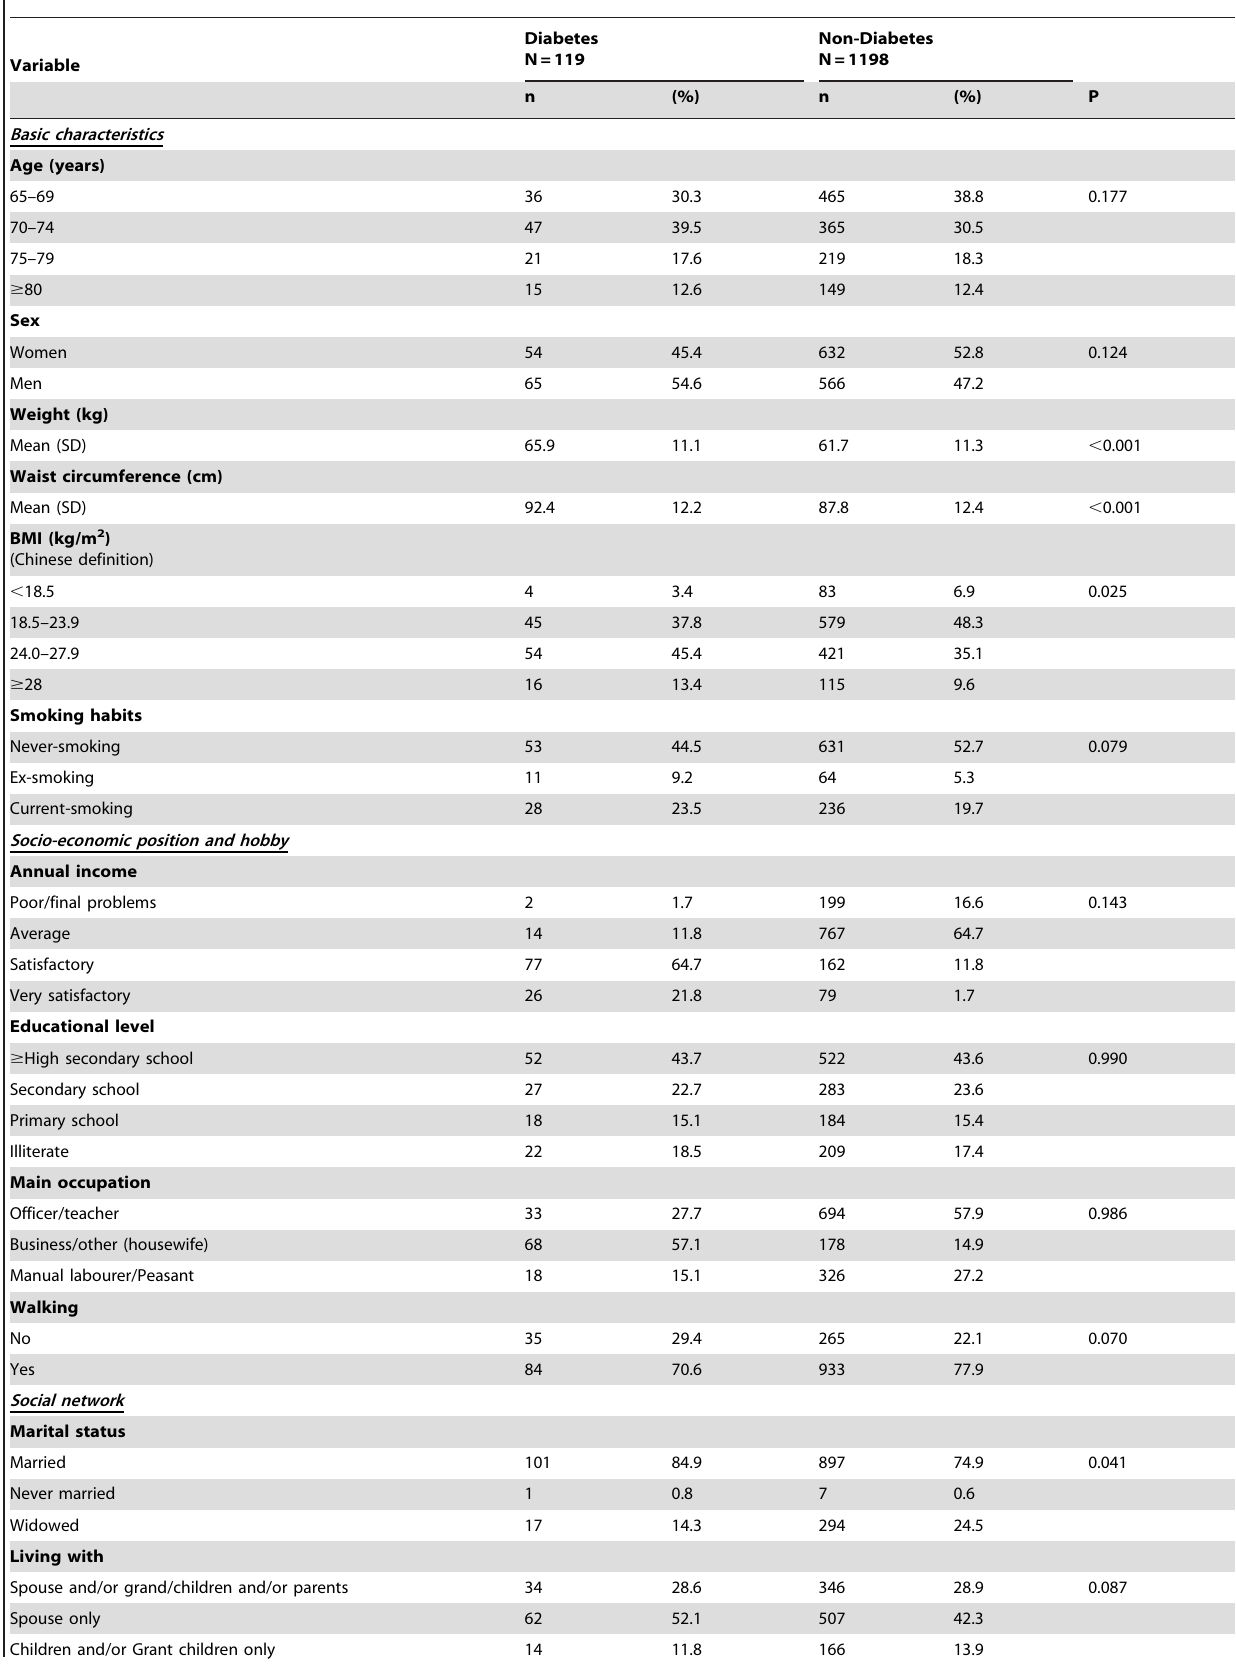
Table 1. Distribution of risk factors for incident diabetes in older people – Hefei cohort study, China.